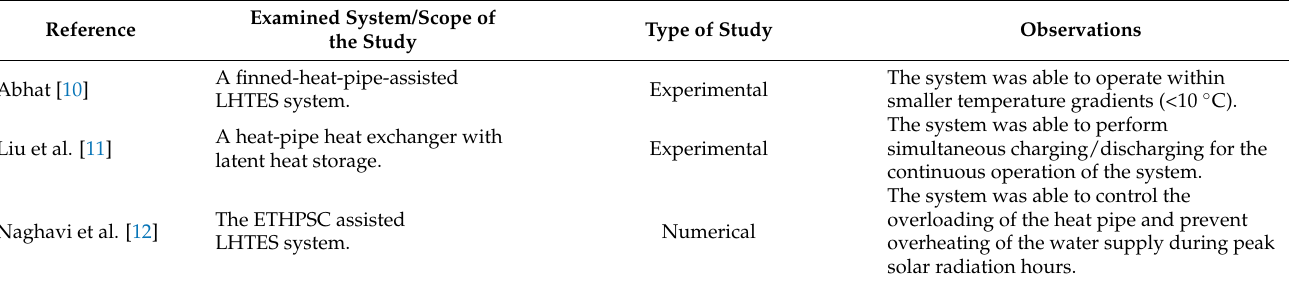
Figure 6. ( a ) Usage of PCM inside the solar collector and ( b ) configuration of examined heat-pipe- based LHTES system in [21]. Table 1. Summary of the literature on heat-pipe-assisted LHTES systems.